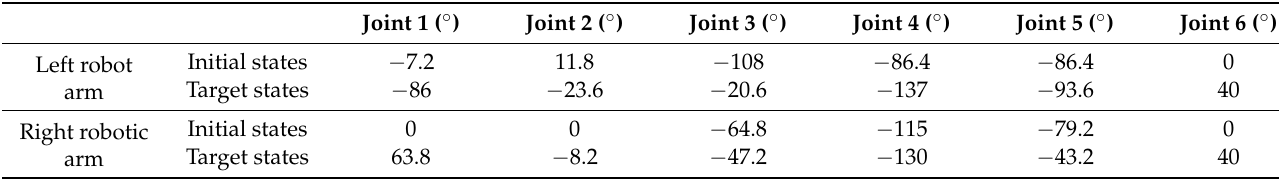
Table 5. Pickable area robotic arm joint